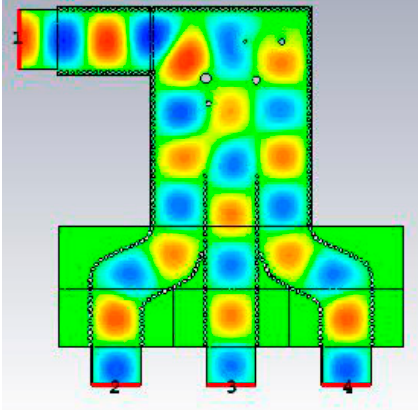
Figure 2. Electric field of three-way H-plane SIW power divider.